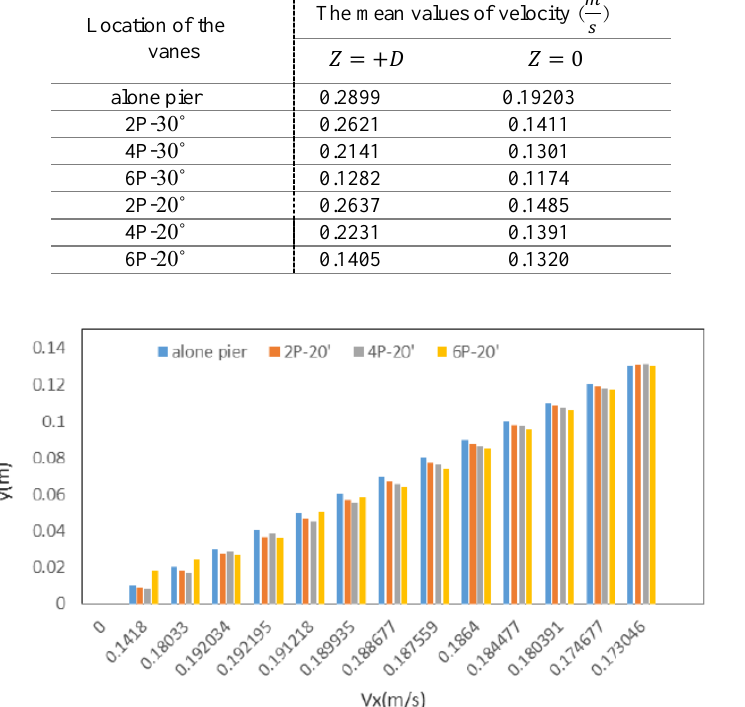
Table 4. The mean values of velocity (m / s) in two axes 𝑍 = 0 and 𝑍 = +𝐷 The mean values of velocity Location of the vanes